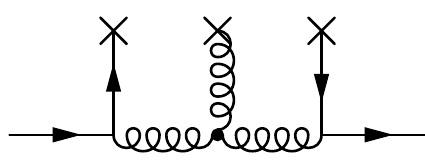
Figure 2 . Contribution of the dimension-six Weinberg operator to the quark propagator. The dotted vertex represents the operator insertion, the crosses indicate interactions with the background and the solid lines depict quark propagators.